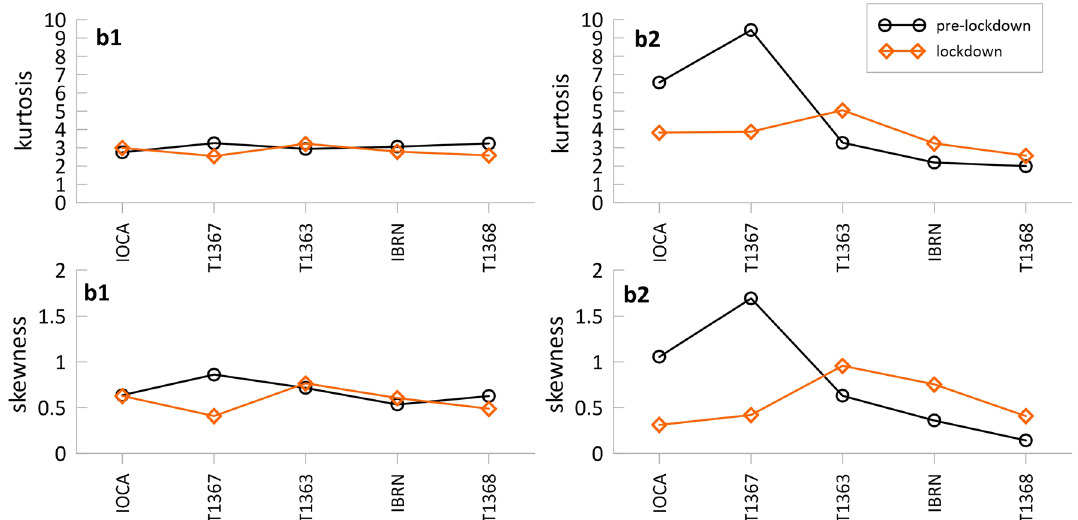
Figure 4. Kurtosis (upper panels) and skewness (lower panels) of the RMS distribution for each station calculated in b1 and b2, during the pre- (black line) and lockdown (orange line)